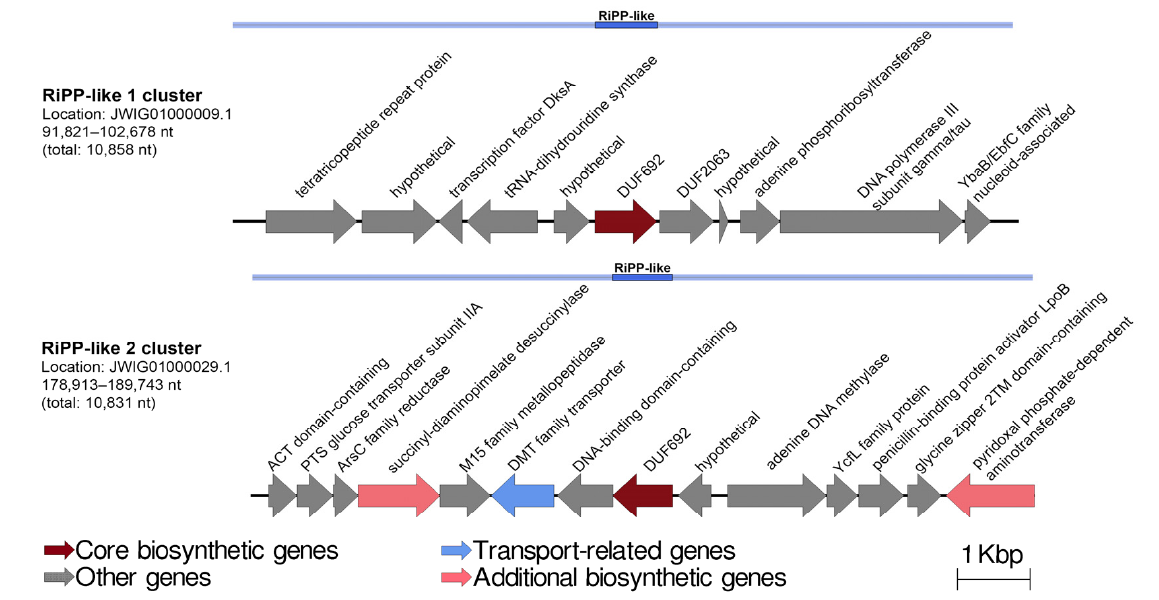
Figure 6. Putative biosynthetic gene clusters for RiPP-like peptides (1 cluster: nucleocidin-like; 2 cluster: brasilicardin-like) in the strains P. distincta and P. arctica A 37-1-2 T.